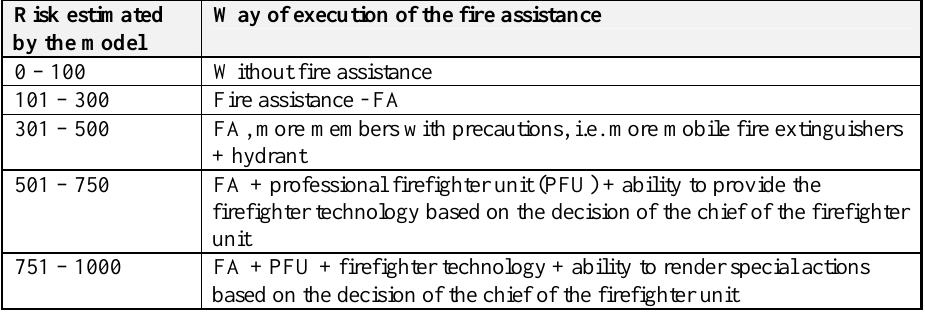
Table 1 – Interpreting Table of the Meaning of the Risks Estimated by the Model Risk estimated by the